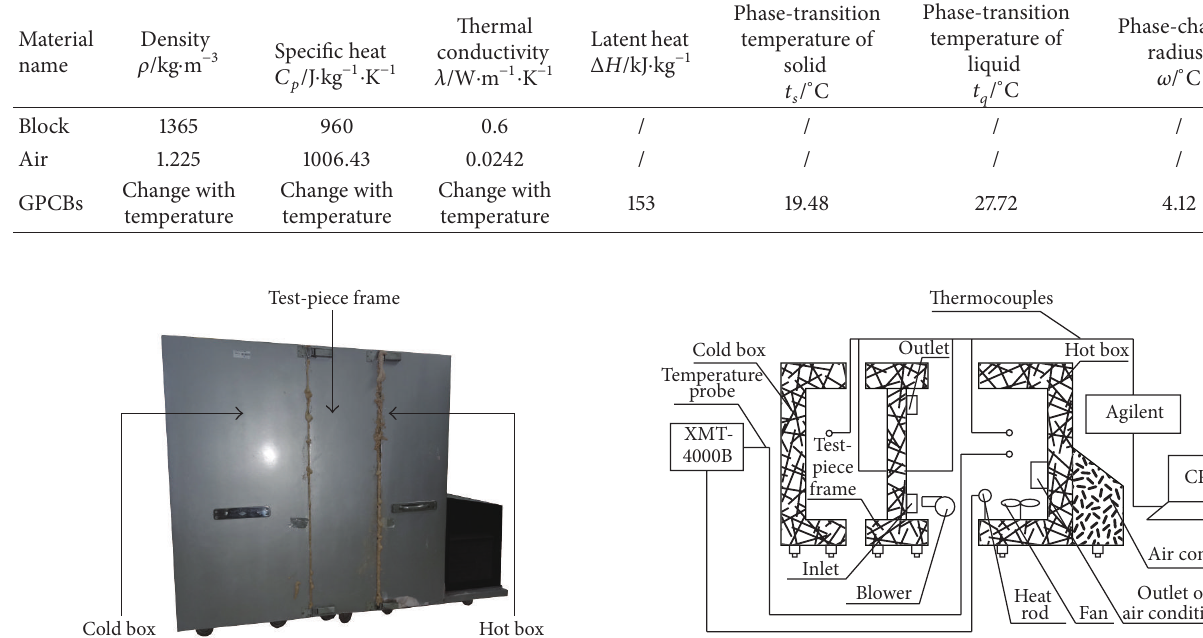
Figure 5: The picture of experimental